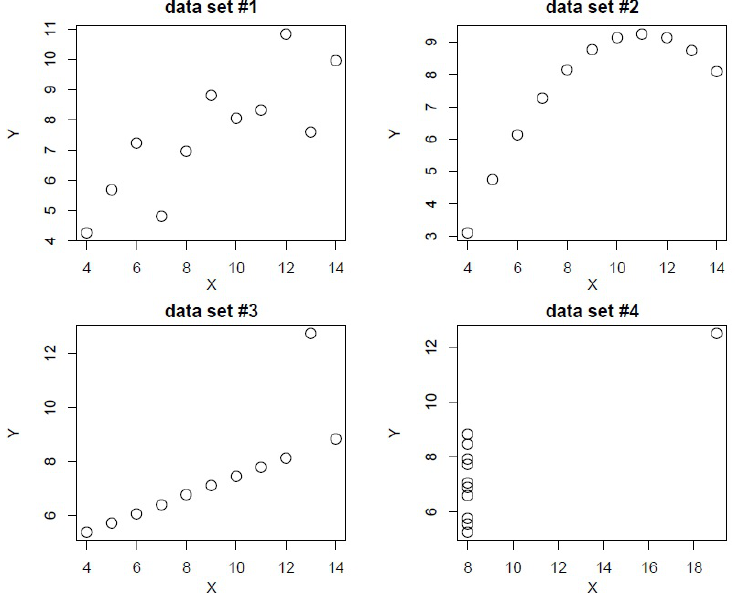
Figure 14. Pearson correlation value higher than 0.8 does not mean the two variables are correlated. The Anscombe’s quartet presents four datasets that share the same mean, same number of values, same Pearson correlation value ( ρ = 0.816) but for which this latter value does not always means the two variables X and Y are correlated. X and Y are not correlated on #4 despite high ρ value. #2 X and Y are perfectly correlated but not in a linear way (Pearson cannot measure other than linear correlations) #1 and #3 illustrates two cases of linear correlation. Figures generated from the data in [79].